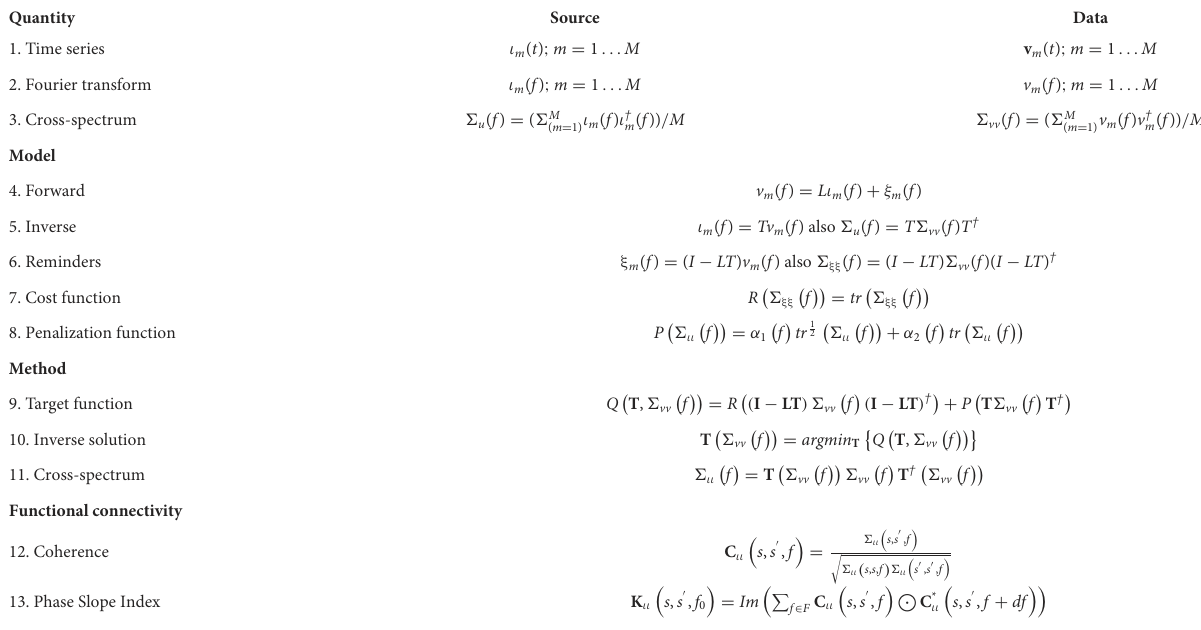
TABLE 2 Summary of the qEEG